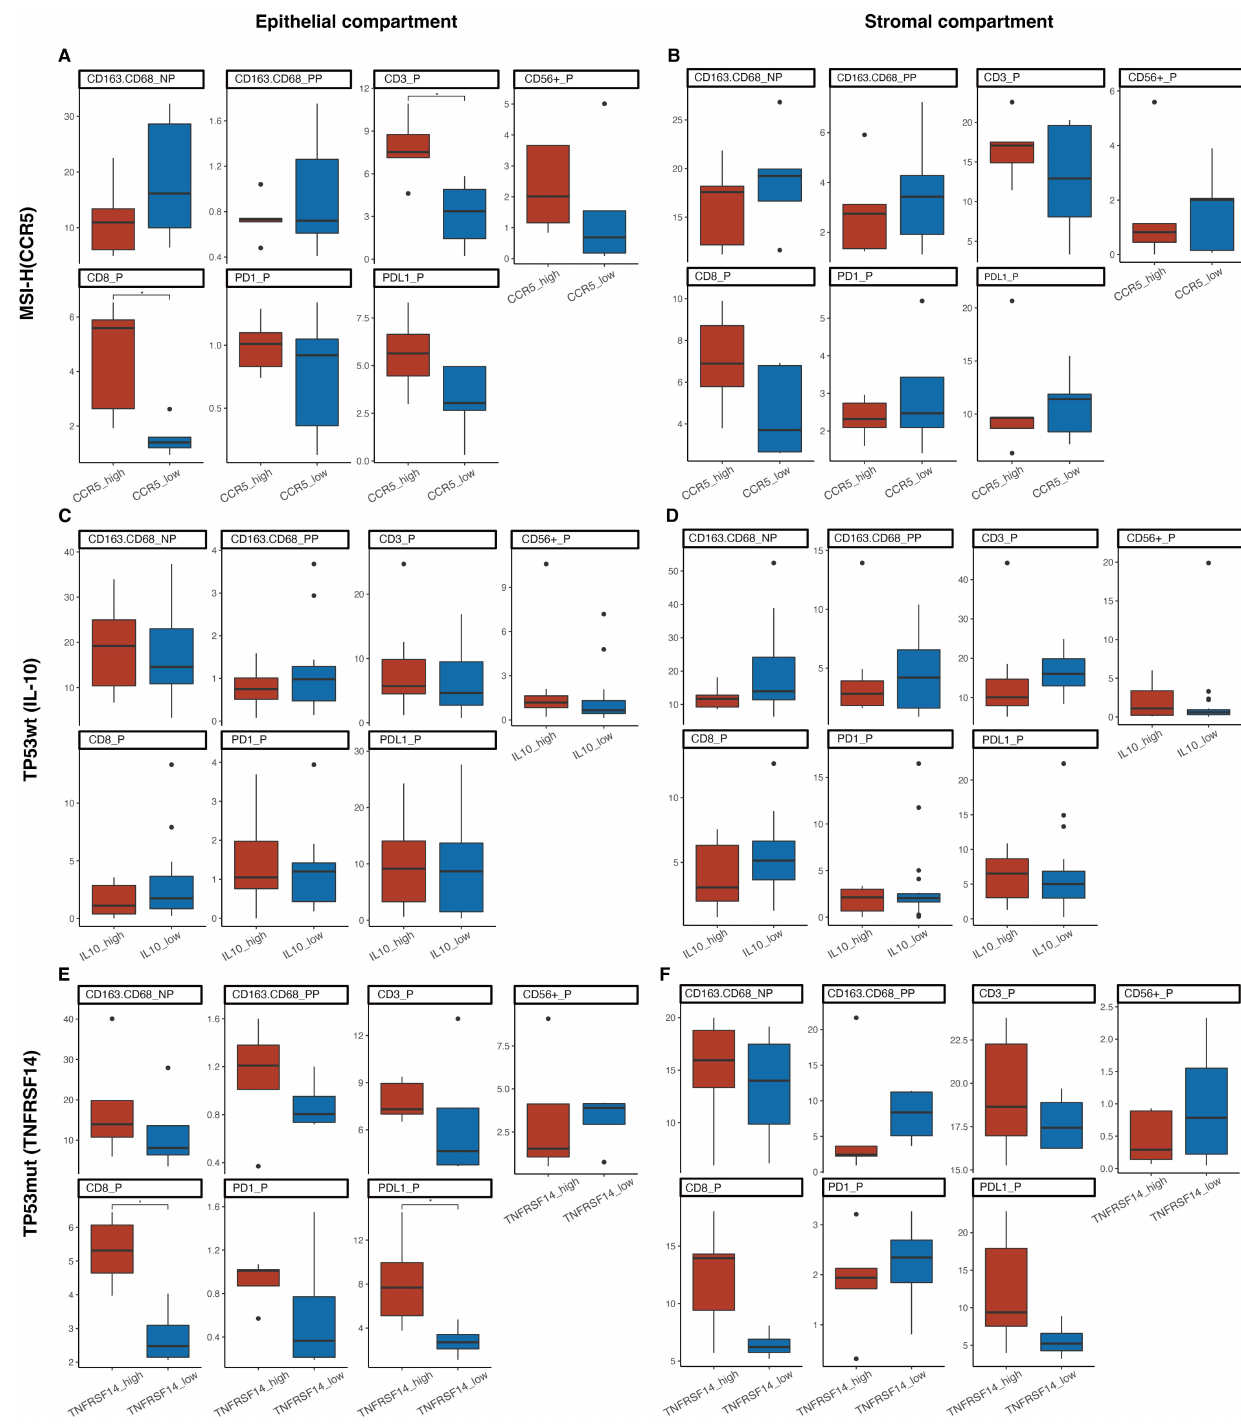
Figure 5. Comparison of tumor immune microenvironment (TIME) landscape between the subsets within molecular subtypes of endometrial cancer sub-stratified by expression of immune-related genes. Intraepithelial and intrastromal positive rates of immune markers were compared. MSI-H subtype was sub-stratified by the expression of CCR5 using median expression level as the cut-off ( A , B ). TP53 -wt subtype was sub-stratified by the expression of IL10 using upper quartile expression level as the cut-off ( C , D ). TP53 -mutant subtype was sub-stratified by the expression of TNFRSF14 using median expression level as the cut-off ( E , F ). Asterisks denote statistical significance; p < 0.05